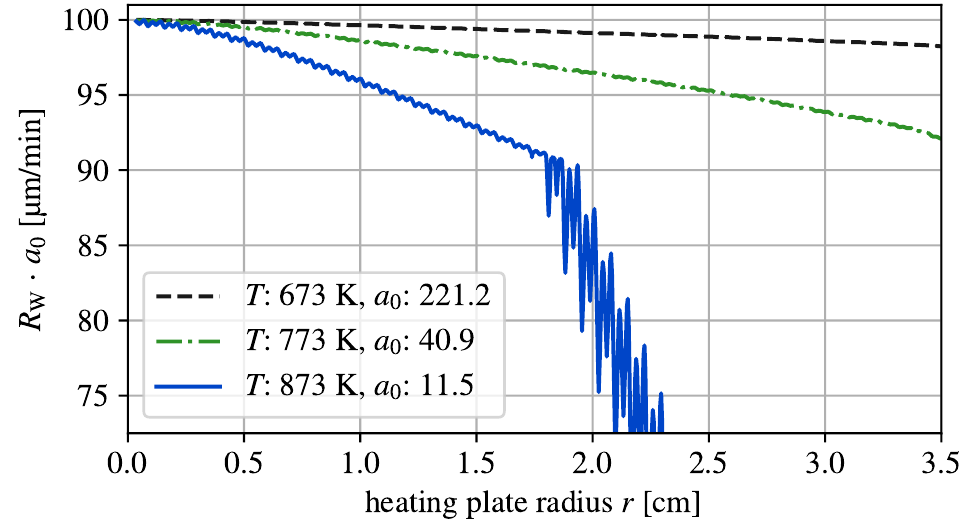
Figure 7. Influence of different T on R W vs. r along the reaction surface below the fibers (a zoomed section is marked orange in Figure 5c). R W is normalized by a constant ( a 0 ). The other process parameters were ˙ V inlet = 300 sccm, ˙ V inlet = 2500 sccm, and P tot = 12 kPa. The strongly oscillating WF 6 H 2 parts of the graph are caused by WF 6 depletion below the